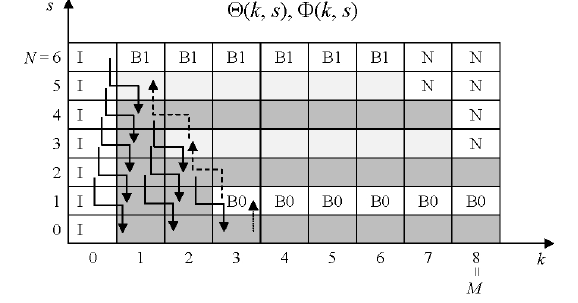
Fig. 2. Grid-cell representation of transformed functions for M = 8 and N = 6, where I-cells are determined from initial condition (Eq. (20)), B0-cells from boundary condition (Eq. (21)), B1-cells from boundary condition (Eq. (22)), and N-cells are